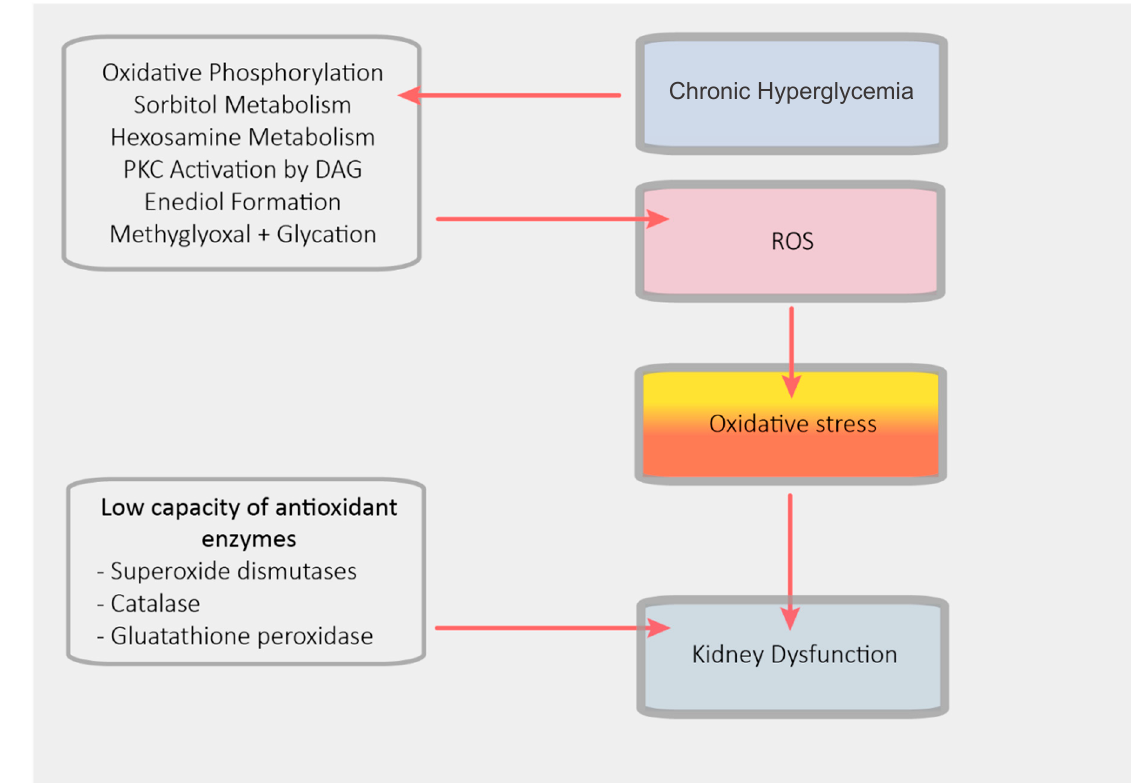
Figure 6. Pathophysiology of diabetic kidney disease. DAG: diacylglycerol; PKC: protein kinase C; ROS: reactive oxygen species.